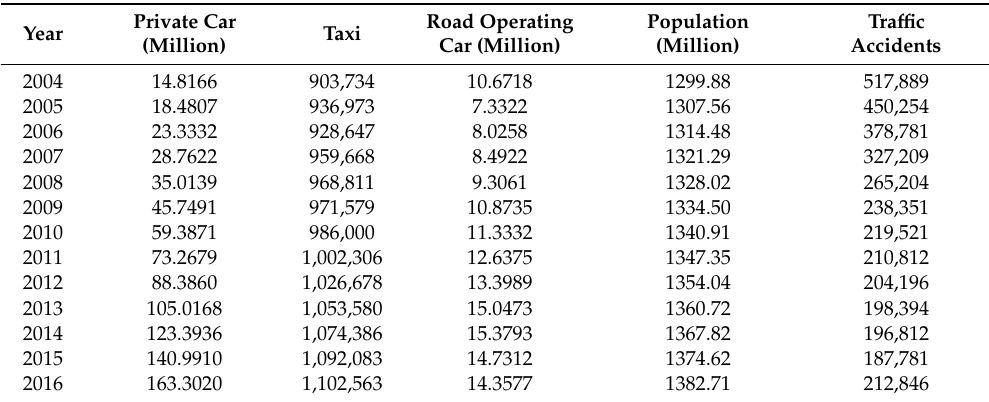
Table 1. The tra ffi c-related statistical data of China from 2004 to